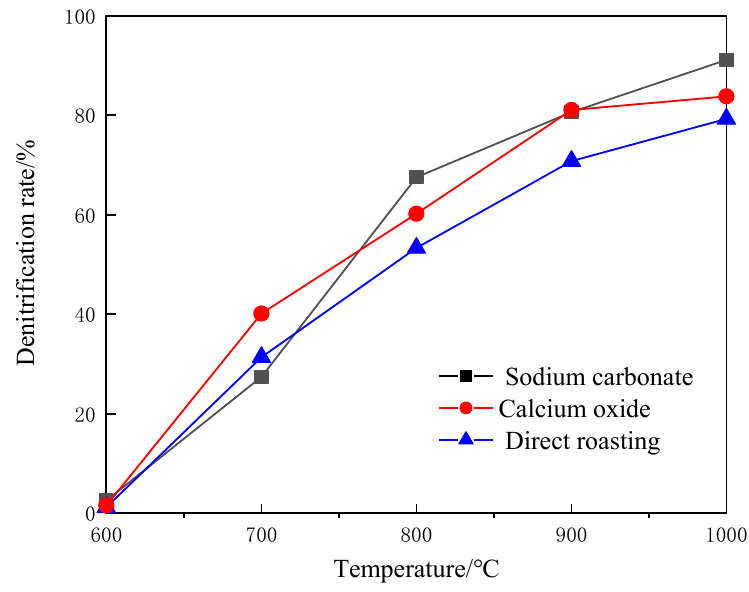
Figure 5. Denitrification rate of aluminum dross varies with roasting temperature.